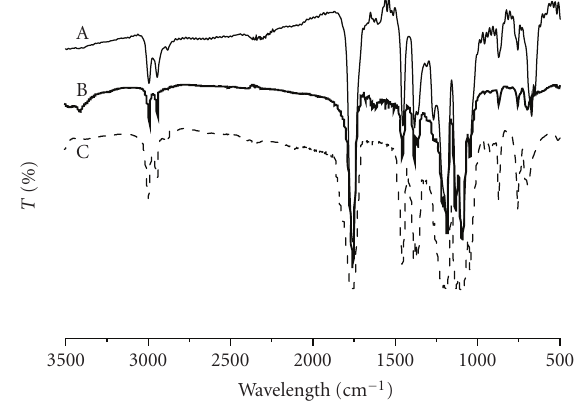
Figure 7: The e ff ect of antioxidant on the structure of PLA by FTIR. A: without antioxidant; B: adding antioxidant before poly- merization; C: adding antioxidant 5 hours during polymerization processing.